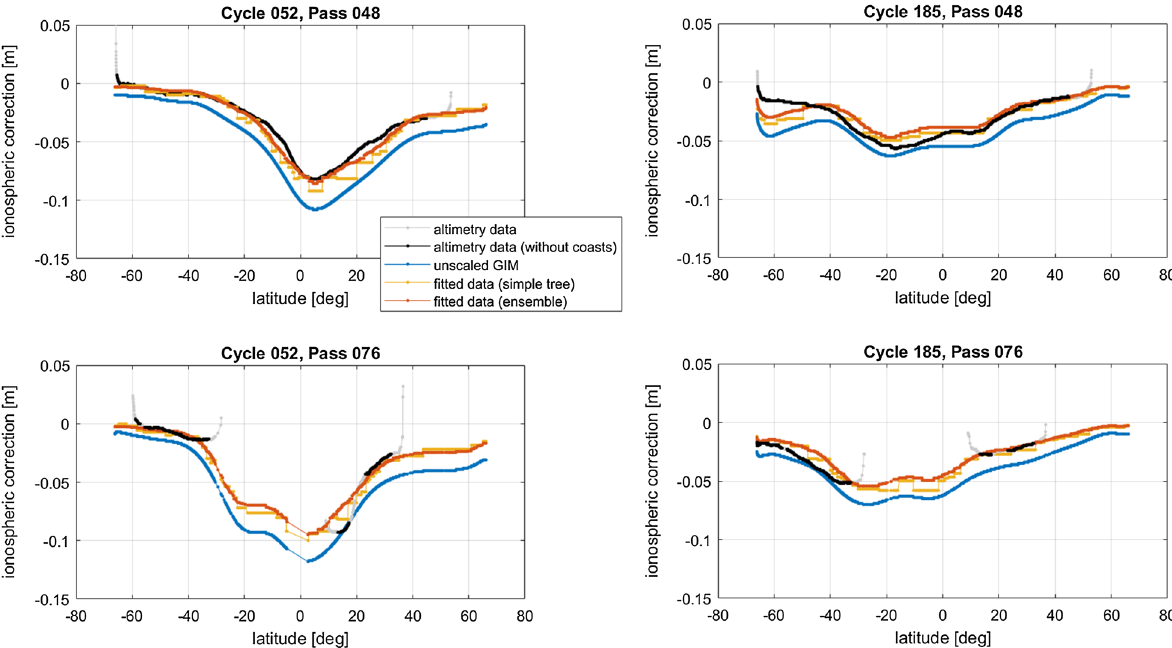
Fig. 1 Three different ionospheric corrections (unscaled GIM model in blue, dual-frequency altimeter correction in grey and black, and correction fitted by machine learning approach a simple regression tree in yellow and boosted ensemble trees in red) for four different pole-to-pole overflights (two cycles and two passes) outside the training